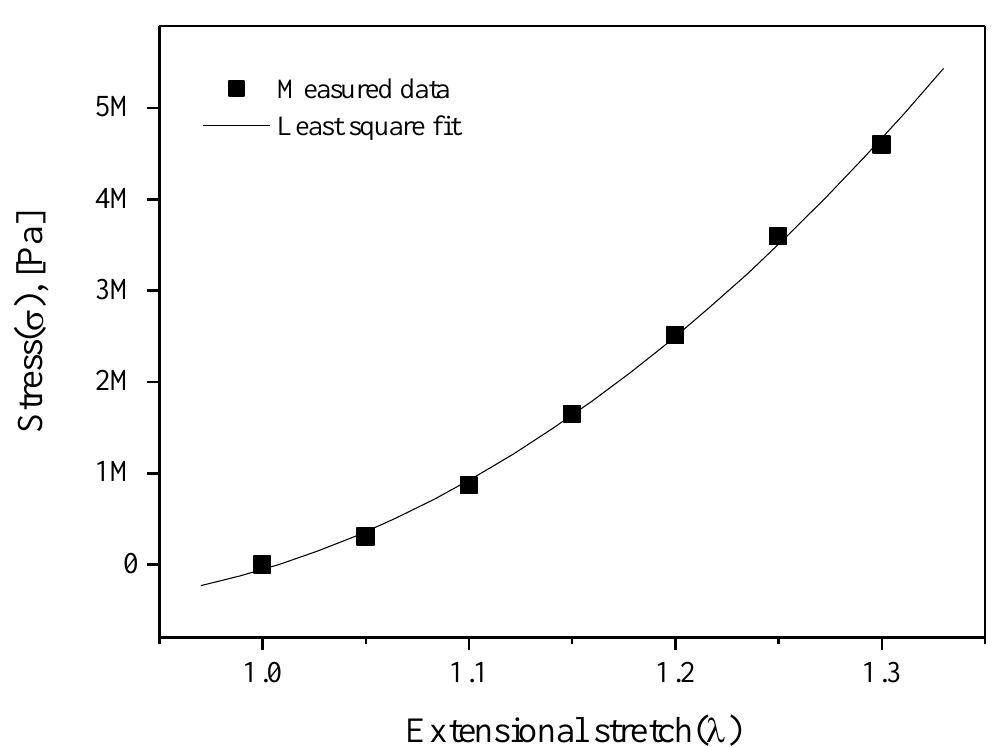
Figure 6. Experimental results and its least square fitting results of the static tension test, (extensional stretch (λ): l/l 0 ).